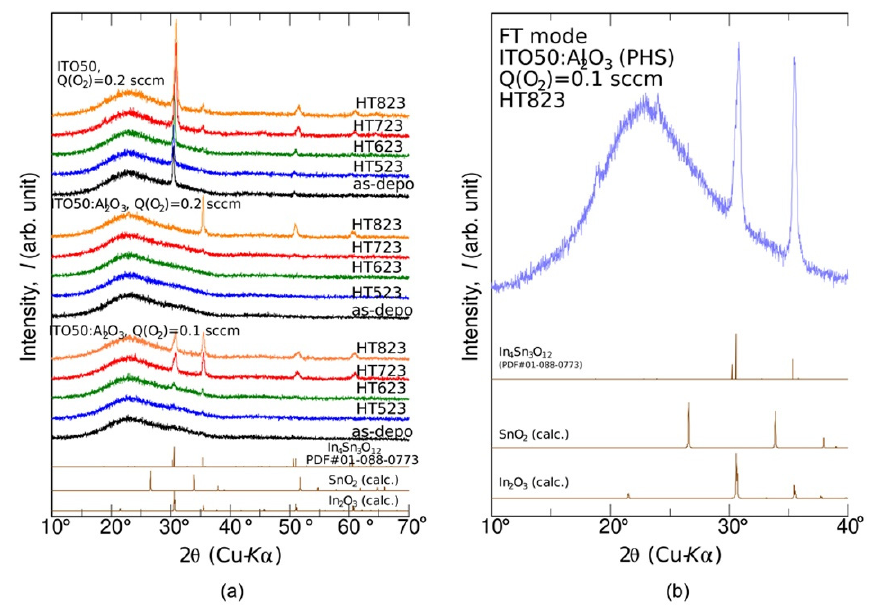
Figure 4. XRD results for ( a ) the as-depo. and HT523-823 ITO50:Al 2 O 3 (PHS) films deposited under W RF (Al 2 O 3 ) = 40 W, Q (O 2 ) = 0.1 sccm and 0.2 sccm compared to ITO50 (PHS) sputtered at Q (O 2 ) = 0.2 sccm [15] and ( b ) HT823 ITO50:Al 2 O 3 (PHS) thin film sputtered at Q (O 2 ) = 0.1 sccm.